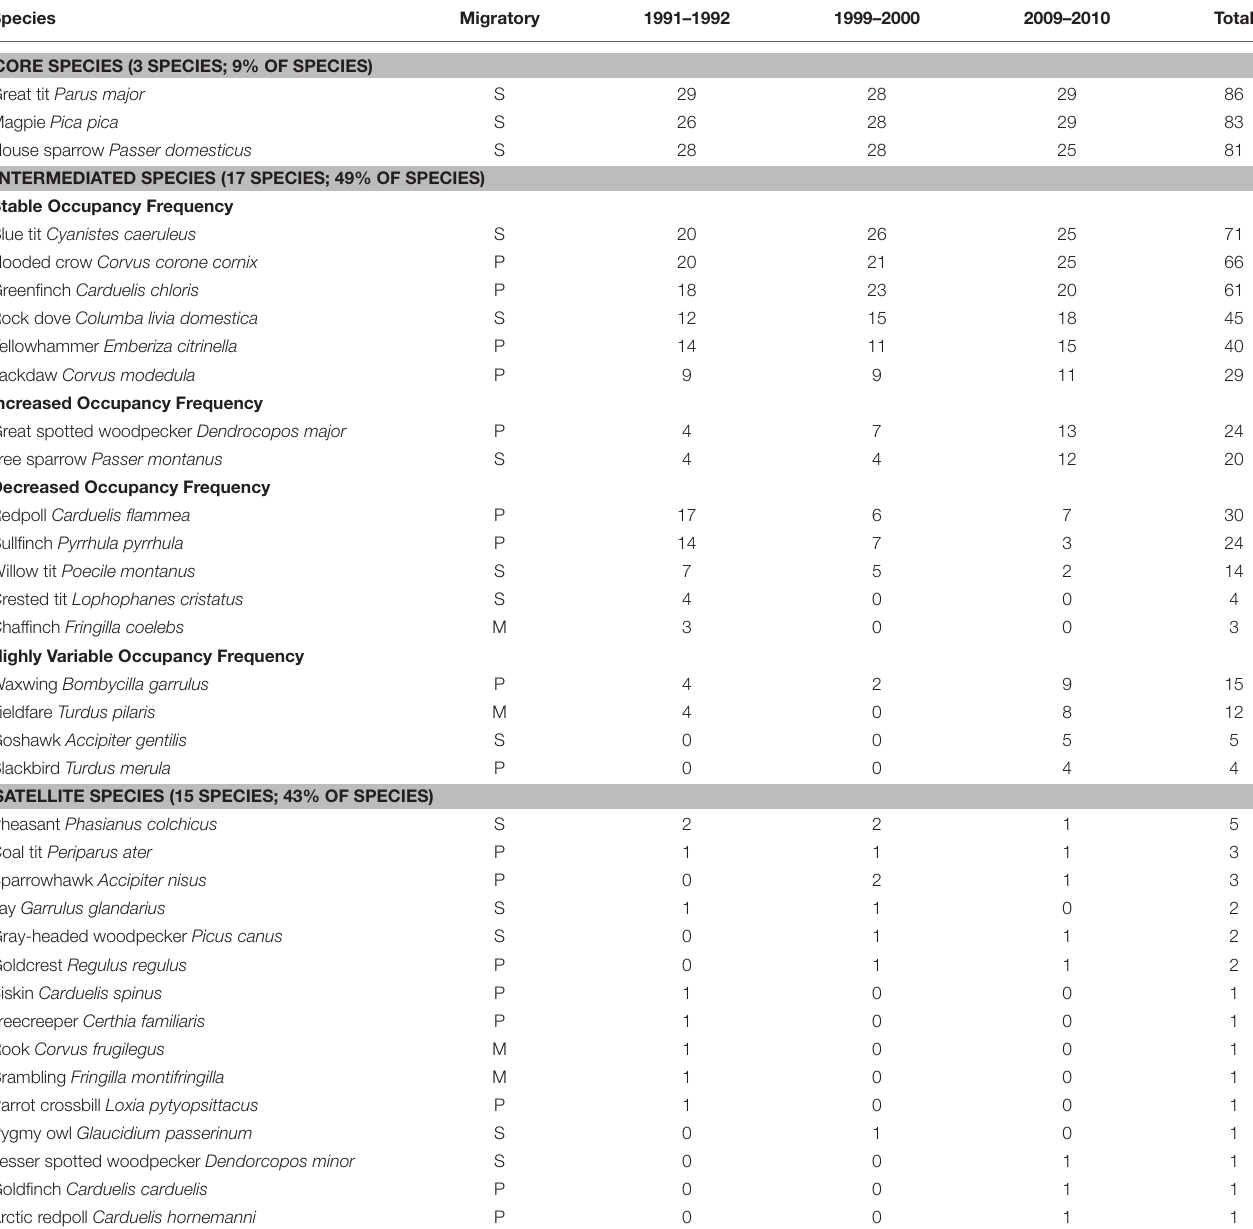
Goldfinch Carduelis carduelis P 0 0 1 1 Arctic redpoll Carduelis hornemanni P 0 0 1